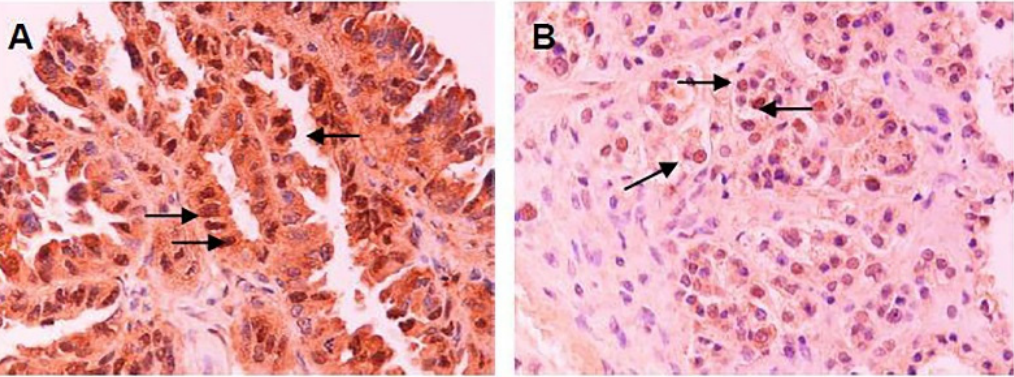
PKM2:pyruvate kinase M2; EOC: epithelial ovarian cancer; *: extreme outliers.